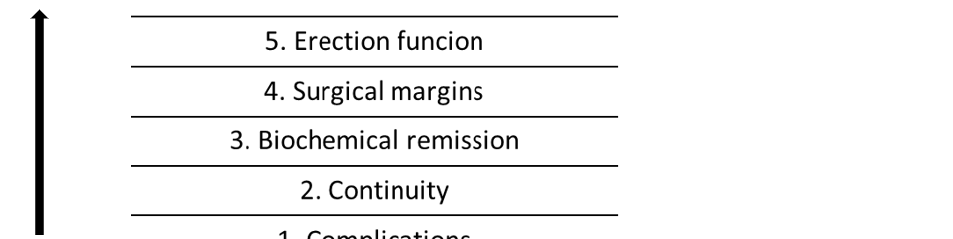
Figure 2. Hierarchy of parameters in relation to the quality of life, from the most important (1) to the least important (5). Table 3. List of unfulfilled pentafect components mentioned by the patient as the most inconven ‐ ient (cases n = 131).